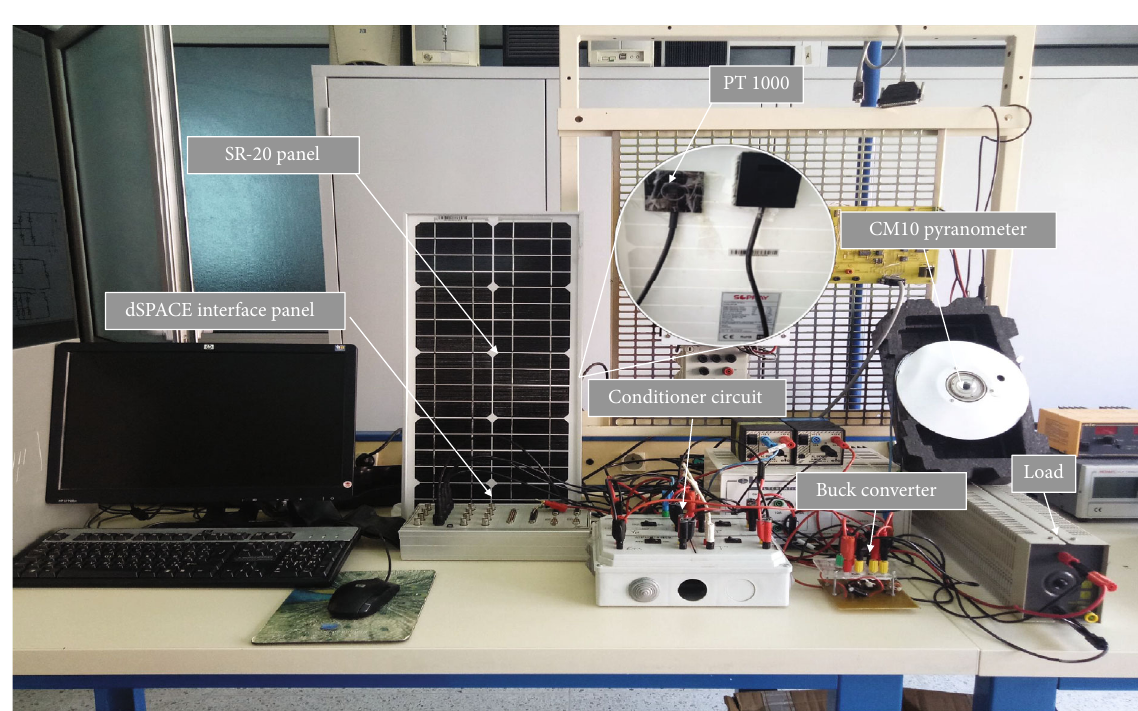
Figure 12: A photograph of the experimental